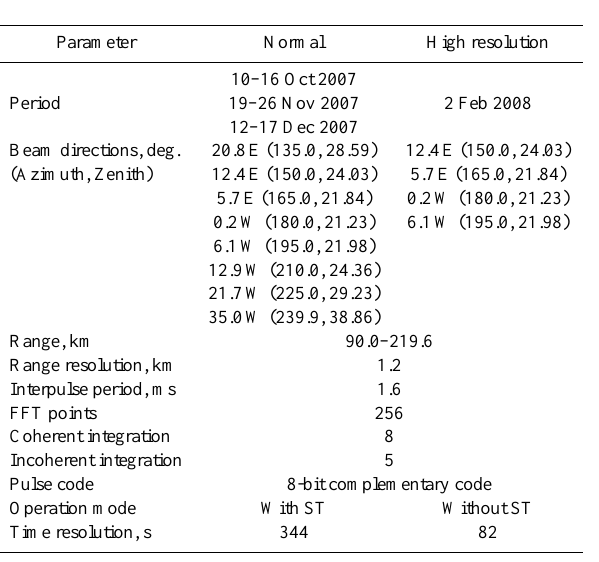
(c) Beam patterns and loci of perpendicularity